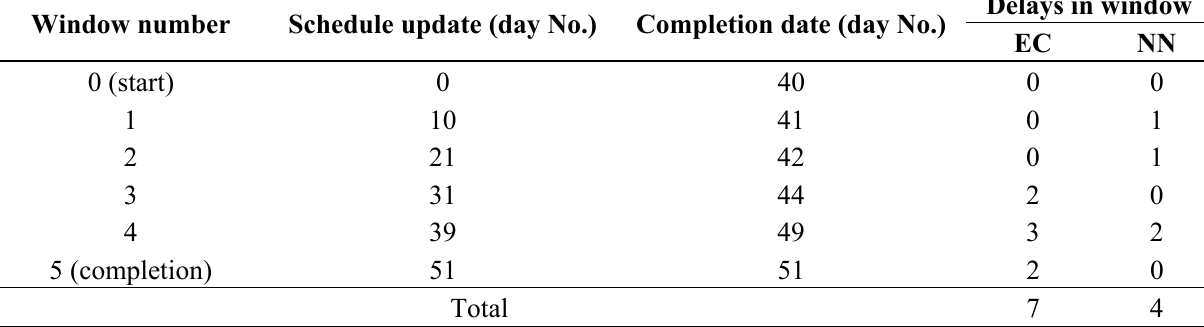
Table 3. “Window” analysis